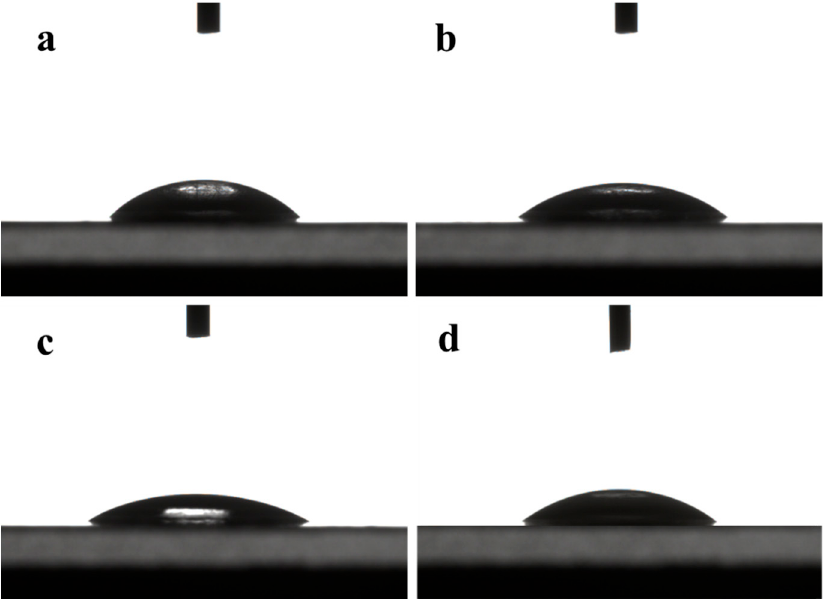
Figure 3. Contact angles of four NF membranes ( a ) DK; ( b ) DL; ( c ) NF270; ( d ) Duracid NF.